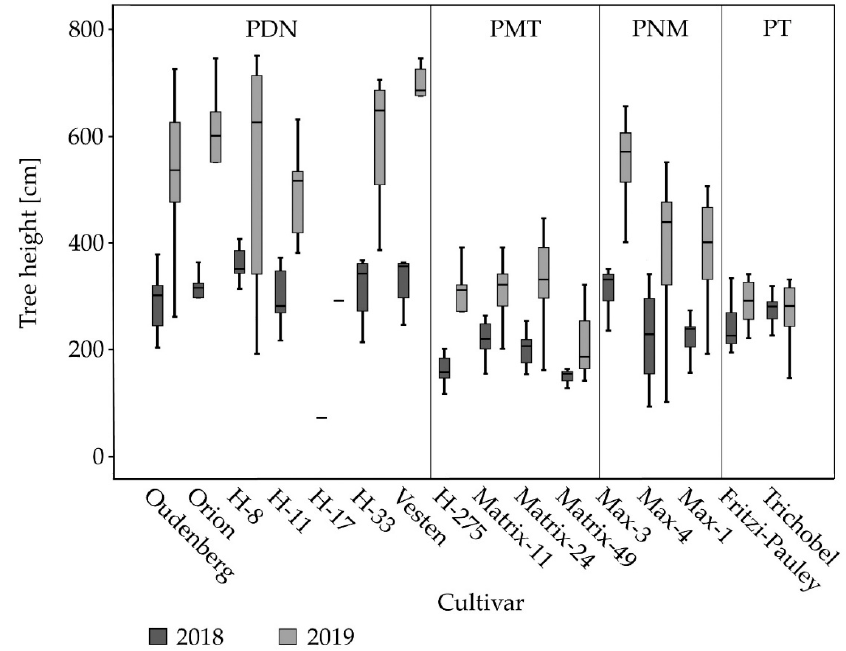
Figure 3. Box plots of tree heights in Almaty at the end of the growing seasons 2018 (dark grey) and 2019 (light grey). Parentages: PDN— P. deltoides x nigra , PMT— P. maximoviczii x trichocarpa , PNM—